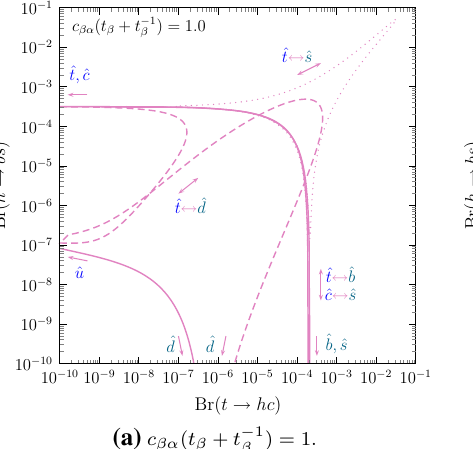
Fig. 4 Br ( h → bs ) vs. Br ( t → hc ) FCNC processes in gBGL models